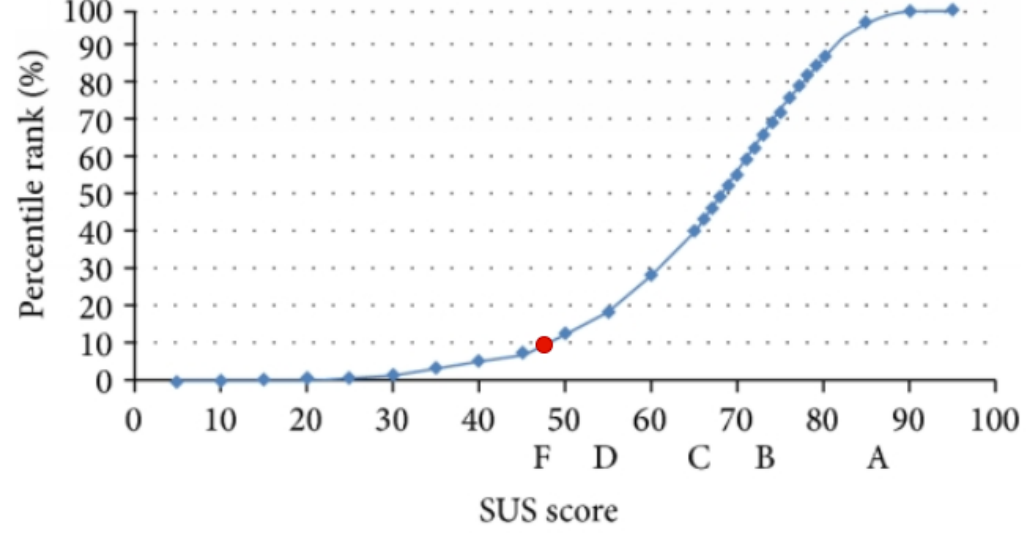
Figure 5. SUS Score percentile ranking. The red dot represents the average score given to the ARK Platform by participants.